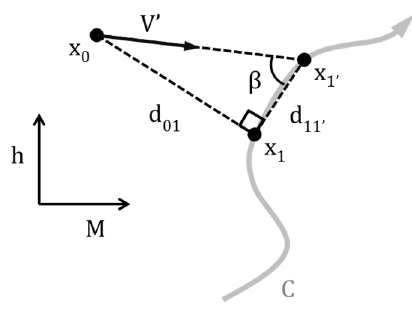
Figure 5. Schematic representation of the proposed path-tracking method.